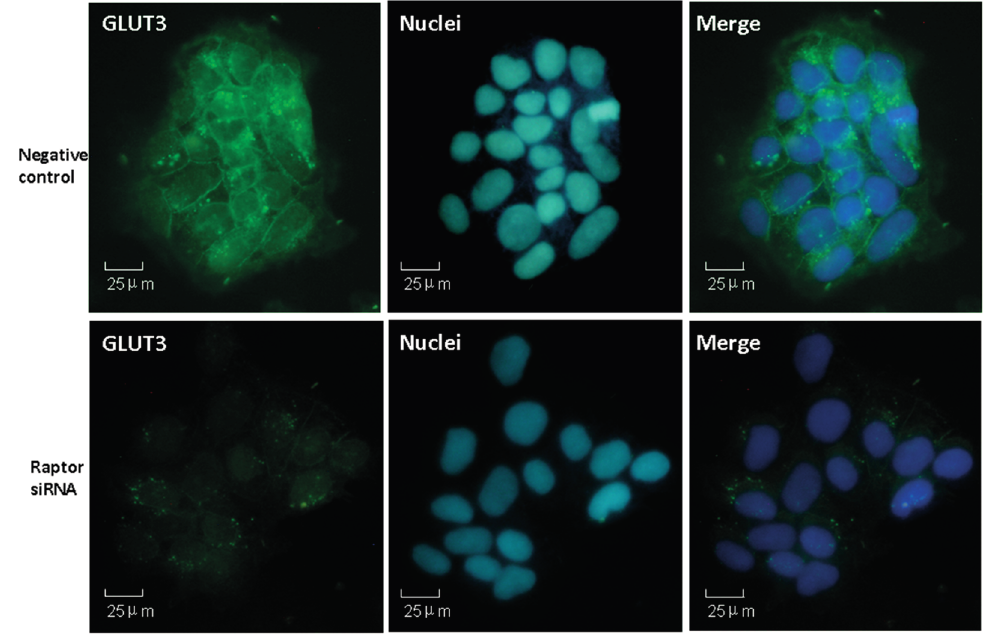
Figure 6. Cellular localization of GLUT3 protein expression in mTORC1 inhibited JEG-3 cells. JEG-3 cells were seeded in 24-well plates and transfected with scrambled ( upper ) or raptor-specific ( lower ) siRNA. GLUT3 protein expression (green) was visualized using immunofluorescence. Nuclei were counterstained with dye 4,6-diamido-2-phenylindole (DAPI)